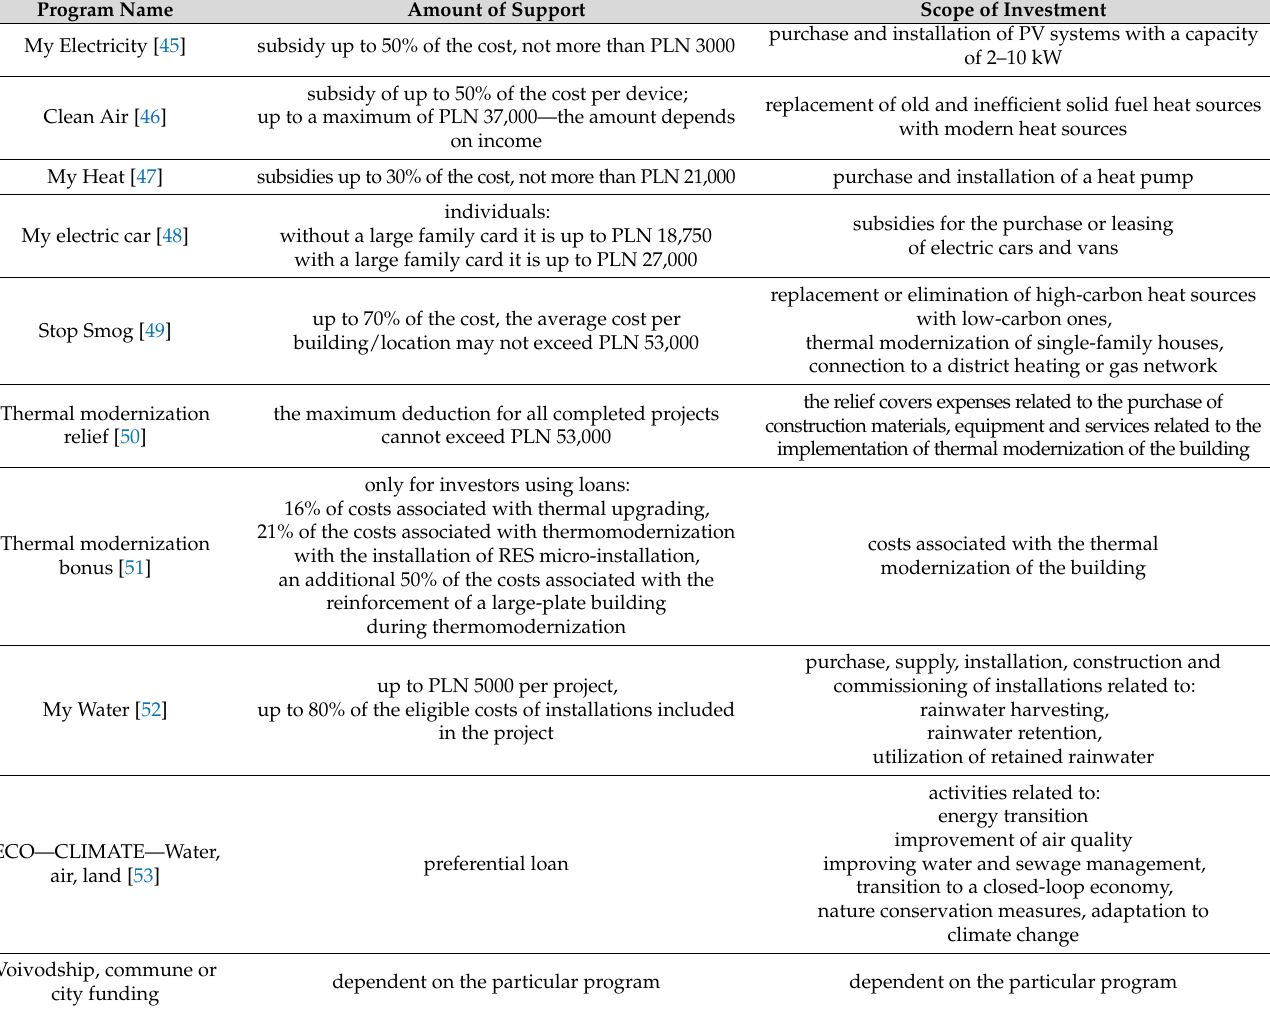
Table 1. Support programs for households in the energy transition